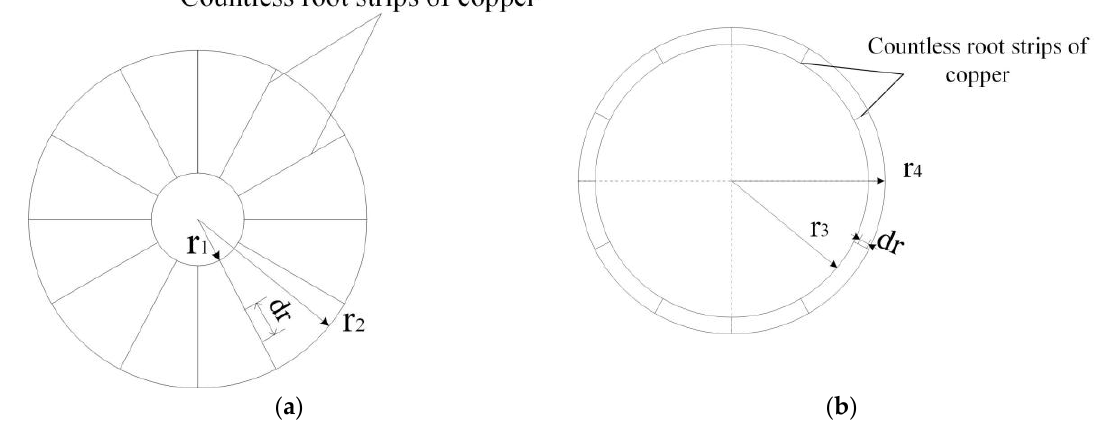
Figure 3. Equivalent structure diagram of copper conductor: ( a ) Axial copper plate; ( b ) Radial copper ring.